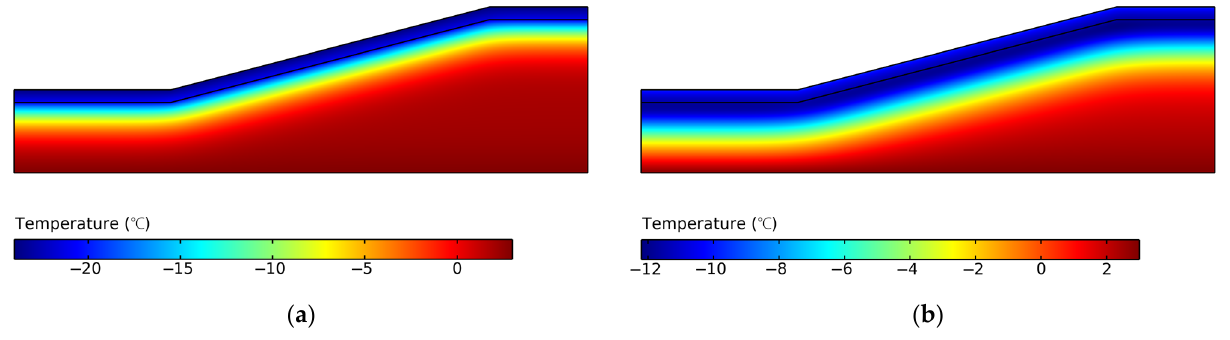
Figure 4. Temperature distributions of the canal at ( a ) 50 h and ( b ) 80 h.